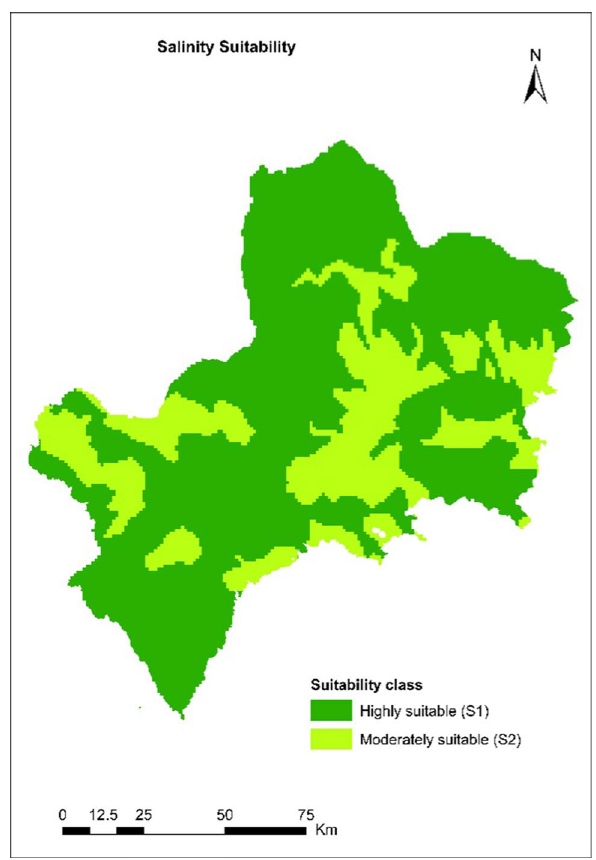
Fig. 6 Salinity suitability